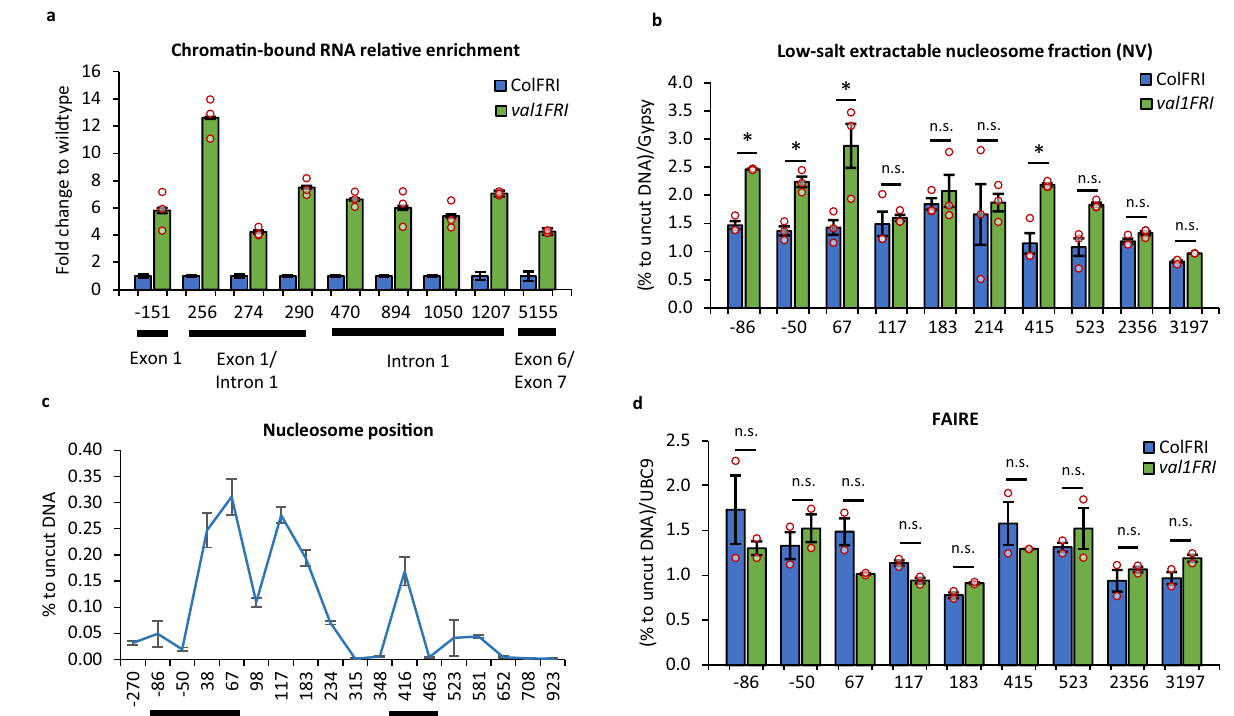
Fig. 4 | VAL1 regulation of FLC chromatin. a Chromatin-bound FLC RNA enrich- ment over the FLC locus is shown as a fold change to wildtype. X-axis shows the midpoint of the amplicon relative to FLC transcriptional start site (TSS), amplicon 0=TSS. N =3 biological replicates, error bars=propagated SEM. b Low salt extractable nucleosome fraction over FLC shown as % recovery to uncut DNA and relative to AT4G07700 (Gypsy-like transposon). X-axis shows the beginning of the amplicon relative to TSS, amplicon 0=TSS. N =3 biological replicates; error bars=SEM; asterisk = P <0.05 from two-tail Student t -test in comparison wildtype vs val1 ; n.s. non-signi fi cant; NV non-vernalized. c Nucleosome position at FLC in ColFRI wildtype. Results from MNase-qPCR assay shown as % to uncut DNA. X-axis